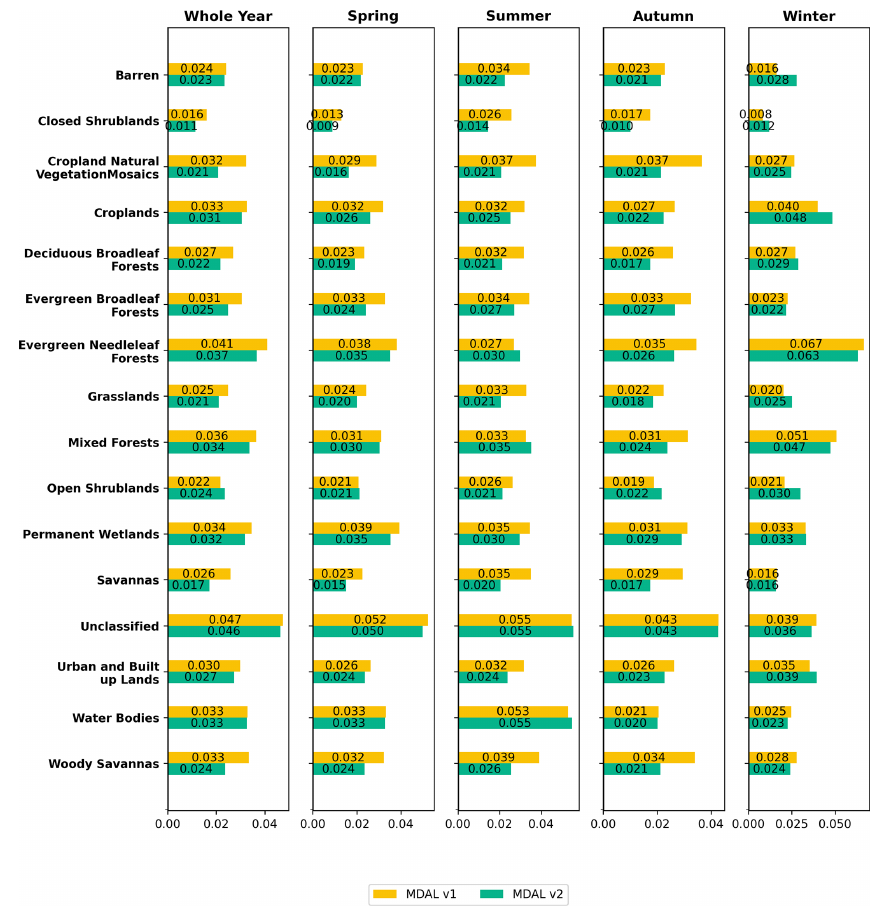
Figure A6. Mean MAE with regard to ETAL by land cover and season (AL-BB-DH). For all pixels the “true” season was taken into account, depending on whether the pixel is located in the Northern or Southern